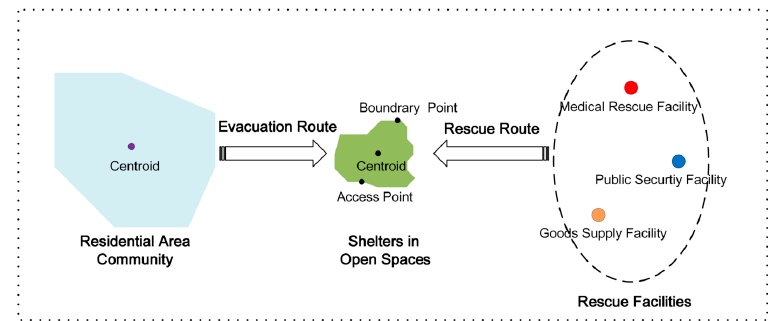
Figure 1. Schematic of evacuation and rescue factors. The evacuation process includes a residential area, shelters, and an evacuation route. The rescue process includes shelters, a rescue route, and rescue facilities for medical purposes, security, or goods supply. Evacuation and rescue constitute disaster